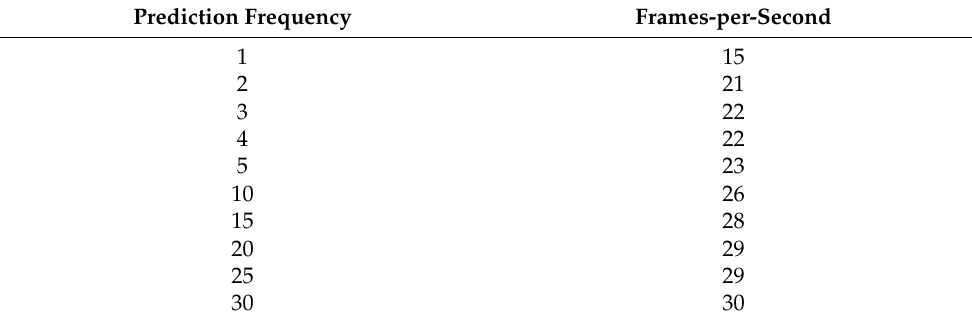
Table 1. Comparison between prediction rate and frame rate during video tests.